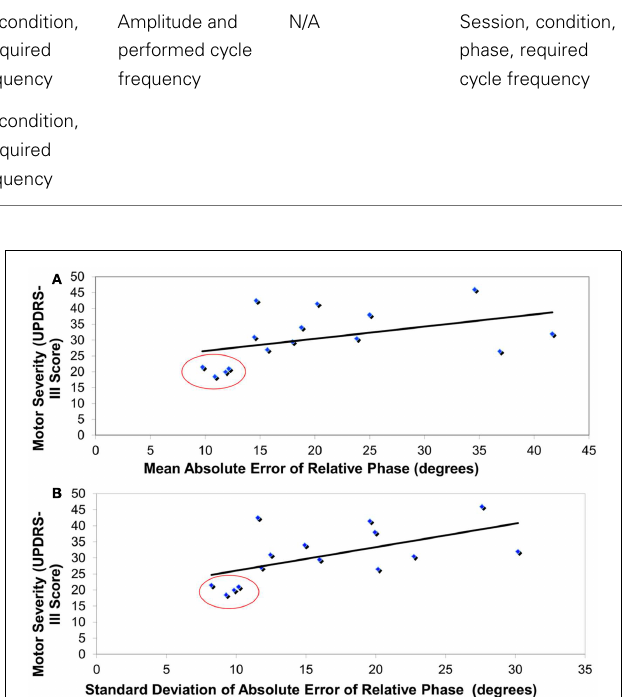
FIGURE 2 | Correlationanalyses revealing that higher motor severity in PD patients “off” (as measured by UPDRS-III) was associated with (A) greater coordination error (absolute error of relative phase, degrees) and (B) greater coordination variability (standard deviation of absolute error of relative phase, degrees) . Red circles highlight the four least severe PD patients that were removed from all other